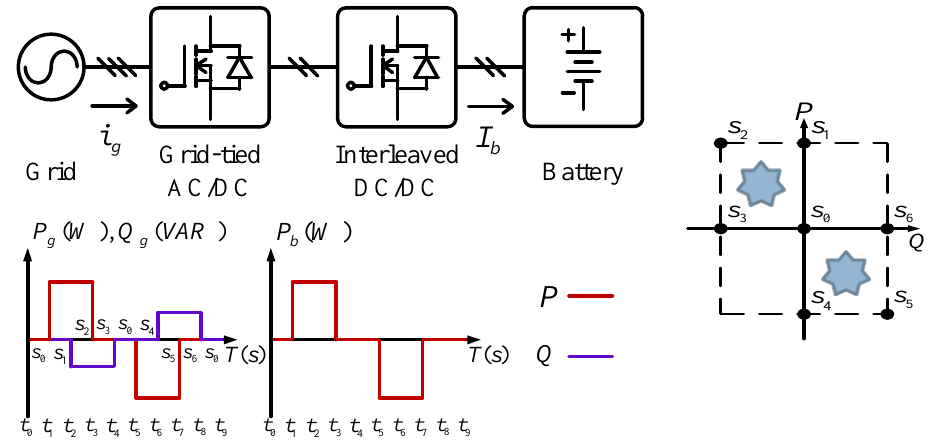
Figure 23. PCS operating in the 2nd and 4th quadrants. Figure 17. The schematic diagram of PCS operating in the 1st and 3rd Figure 17. The schematic diagram of PCS operating in the 1st and 3rd quadrants.